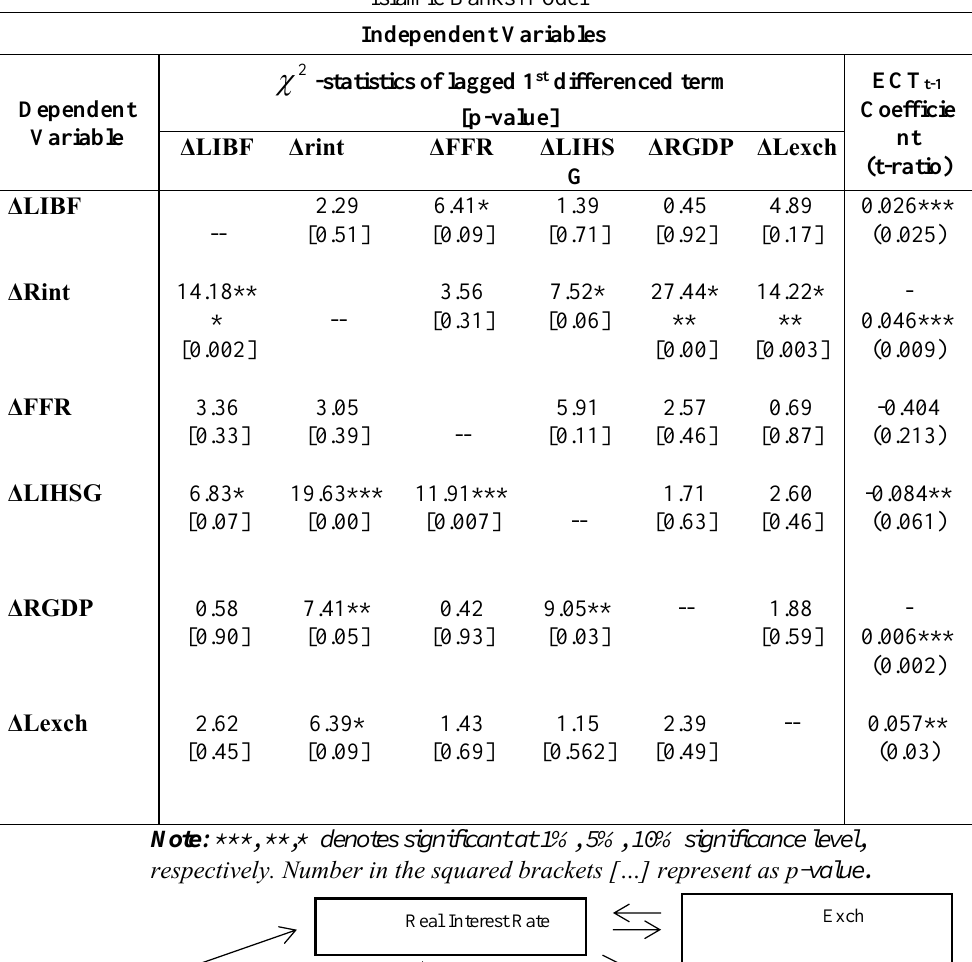
Table 2 Granger Causality Test Matrix Result for Financing Growth of Islamic Banks Model